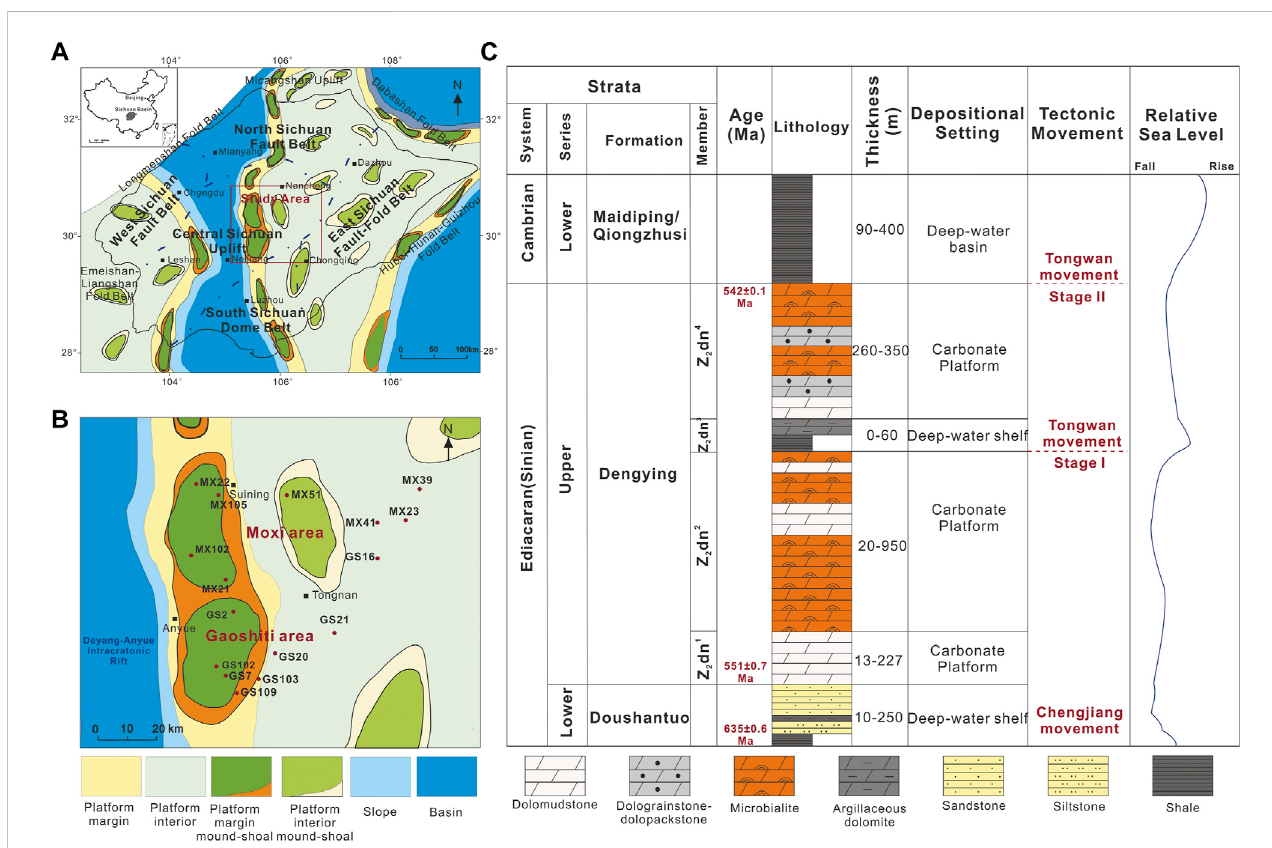
FIGURE 1 Geological setting of the Gaoshiti — Moxi area. (A) Location of the Gaoshiti — Moxi area in the Sichuan Basin (modi fi ed from Wang et al., 2021; Lan et al., 2022b). (B ) Wells distribution in the Gaoshiti — Moxi area. (C) Stratigraphic column of the Dengying Formation in the Gaoshiti — Moxi area (modi fi ed from Hu et al., 2018; Zhou et al., 2020; Wang et al., 2021; the age data are from Condon et al., 2005; Chen et al.,